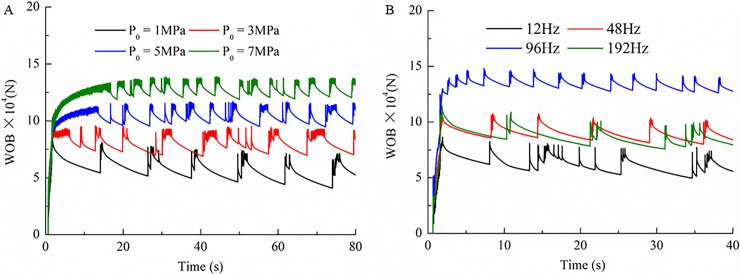
Effect of amplitude and frequency of pulse pressure on weight on bit.(A) Frequency of pulse pressure f = 24Hz. (B) Amplitude of pulse pressure P0 = 2MPa. https://dx.doi.org/10.17504/protocols.io.ke8cthw.